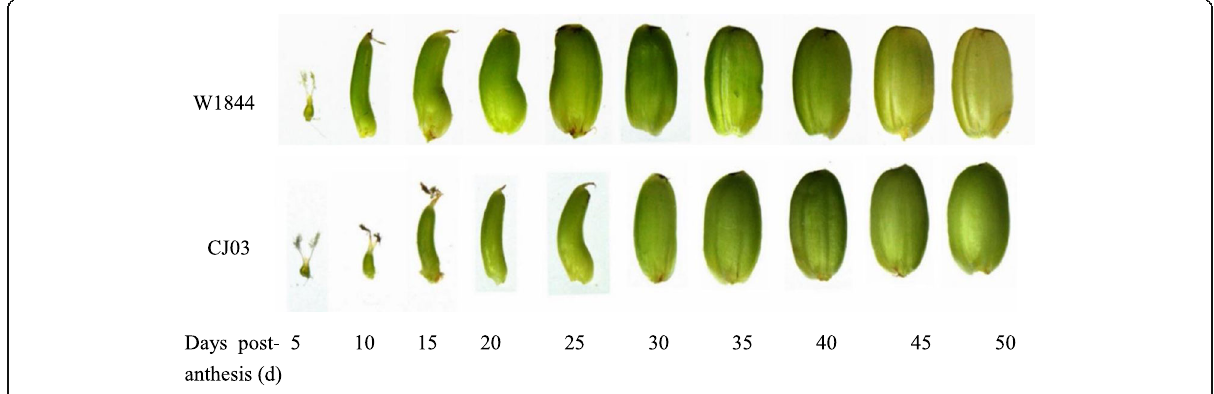
Fig. 3 Dynamic development graph of inferior spikelets in the test materials during the grain filling stage